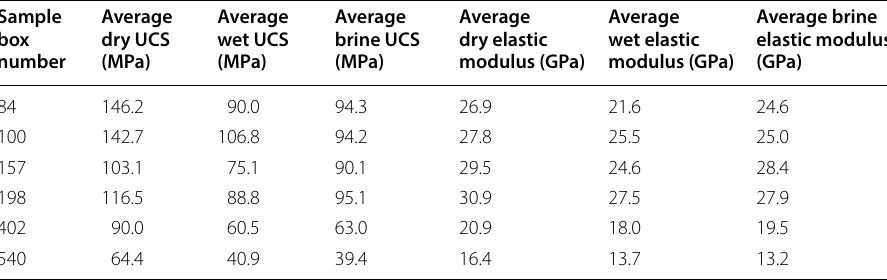
Table 5 Summary of the average dry, water‑saturated (wet), and brine‑saturated (brine) uniaxial compressive strength experiments performed on the six sandstones sampled from exploration well EPS‑1 at the Soultz‑sous‑Forêts geothermal site